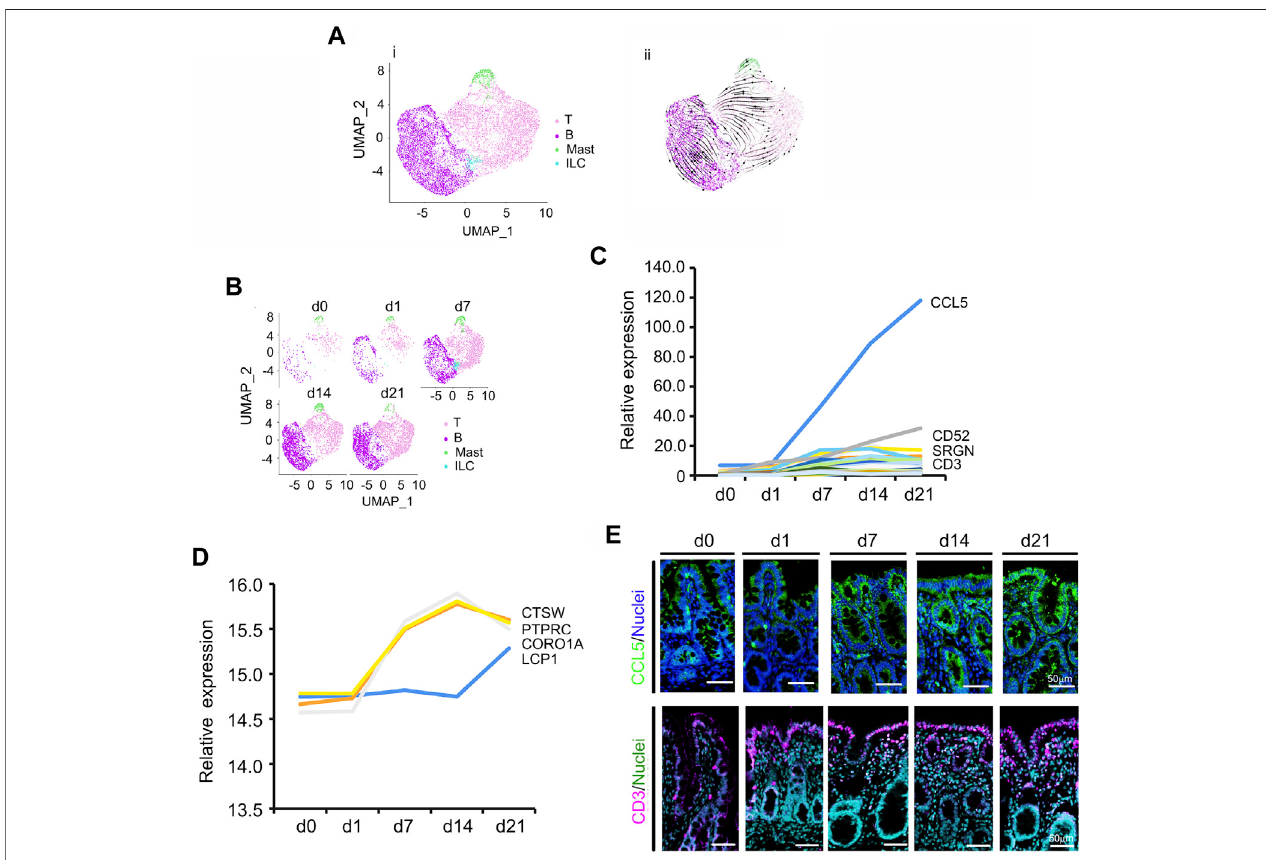
FIGURE 2 | Increase in piglet cecal immune cells (Im) during the neonatal window. (A) Cell type clusters for Im for the cells together from the fi ve time points by UMAP.(i)UMAPofImsinglecells(points),coloredbyclusterassignment.(ii)RNAvelocityvectorprojectiononUMAPplot(Thearrowindicatedthedevelopmentaltrend). (B) Im population changes during development (from d0 to d21). (C) Relative expression pattern of the top 50 speci fi cally expressed genes in Im. The gene level was based on the expression of each gene in all the cell, and it is relative level from scRNA-seq analysis. The Y-axis presents the relative expression, and X-axis shows the time points. (D) Relative protein levels of some of the top 50 speci fi cally expressed genes from the proteomic analysis. The Y-axis presents the relative expression, and X-axis shows the time points. (E) The protein levels of CCL5 and CD3 in the different samples at different time points according to IHF. Scale bar: 50 μ m.